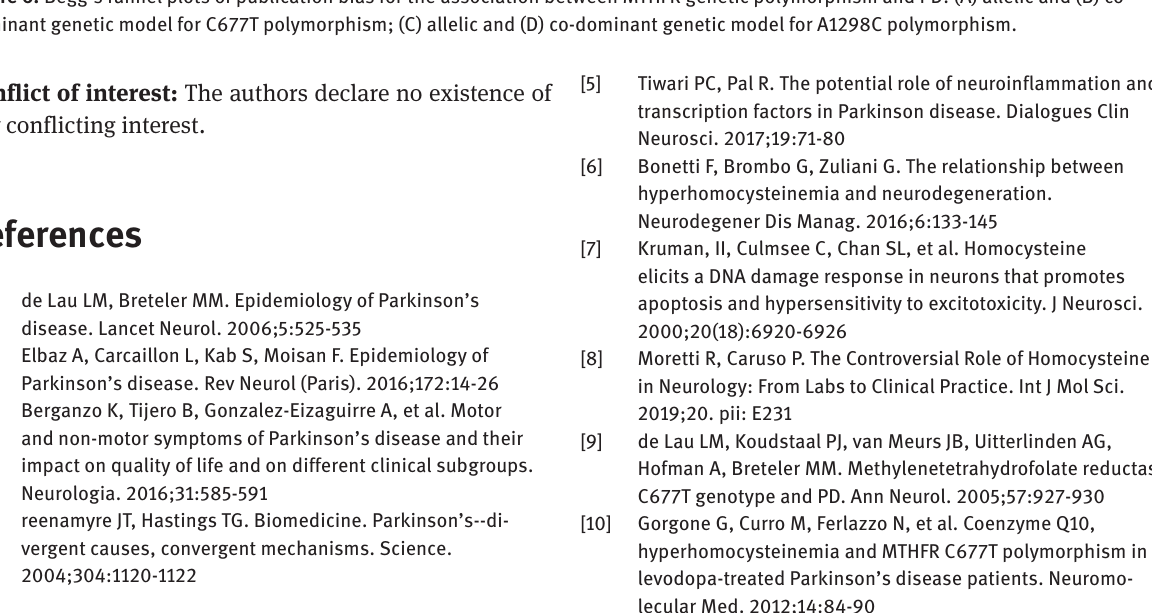
Figure 6: Begg’s funnel plots of publication bias for the association between MTHFR genetic polymorphism and PD: (A) allelic and (B) co- dominant genetic model for C677T polymorphism; (C) allelic and (D) co-dominant genetic model for A1298C